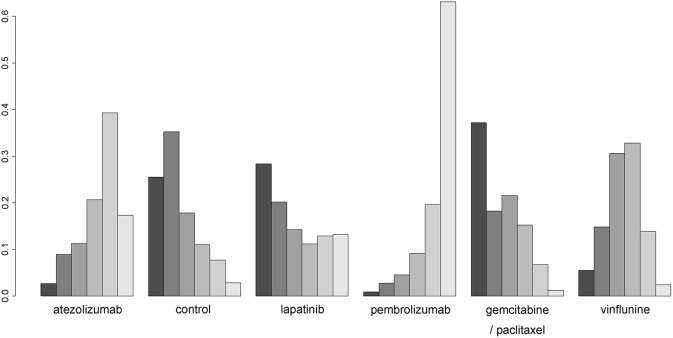
Rankograms for second-line treatment network of overall survival. The size of each bar corresponds to the probability of each treatment to be at a specific rank.